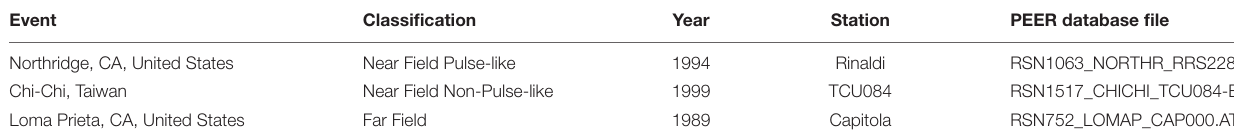
TABLE 1 | Identifying information for ground motions used in testing.